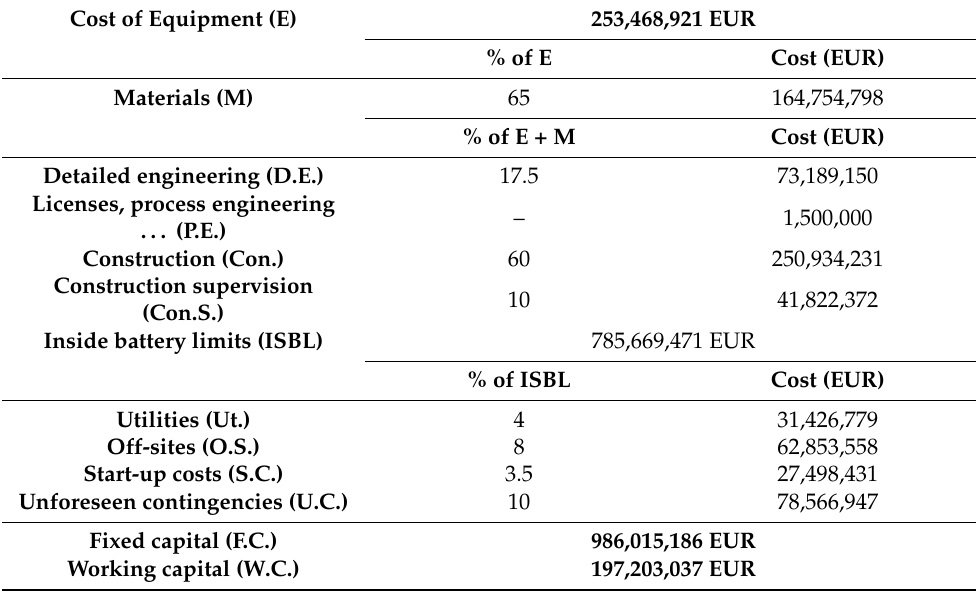
Table 18. Percentage